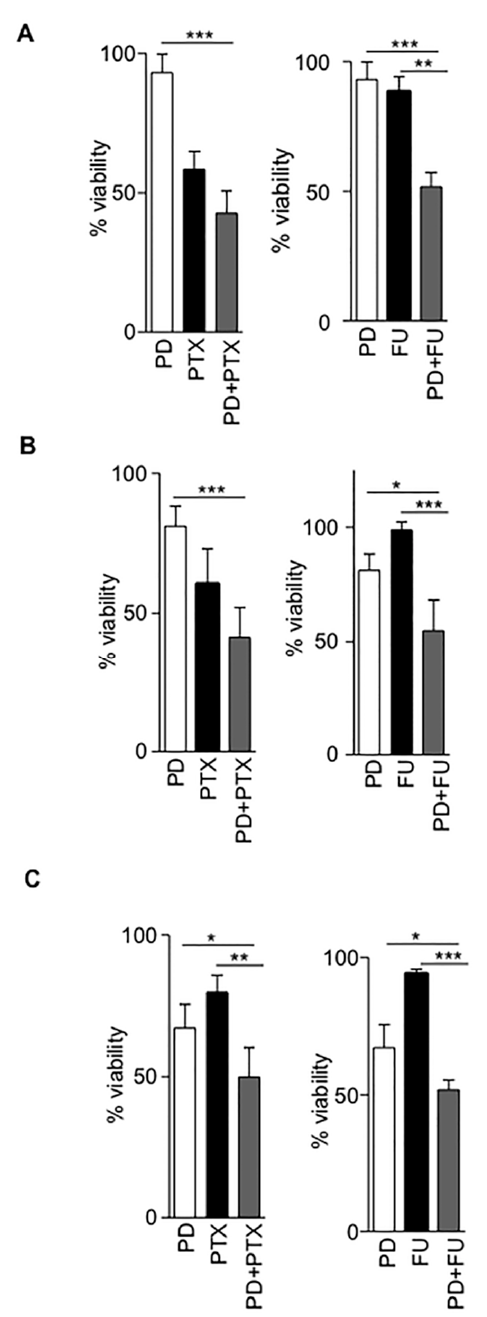
Figure 5. Pharmacological activation of SAMHD1 enhances cytotoxicity of antimetabolites. ( A – C ) E ff ect on cell viability of palbociclib–pemetrexed combination in TZM-bl, T47D and MDA-MB-468 cell lines, respectively. Left panels, cytotoxic activity of palbociclib alone (5 µ M, white bars), pemetrexed alone (black bars at 0.2, 1 or 0.04 µ M for TZM-bl, T47D and MDA-MB-468 respectively) or the combination of both drugs at the same concentration (grey bars). Right panels, cytotoxic activity of palbociclib alone (5 µ M, white bars), fluorouracil alone (5 µ M, black bars) or the combination of both drugs at the same concentration (grey bars). Drug concentrations were chosen depending calculated CC 50 under specific experimental conditions (Table S1). * p < 0.05; ** p < 0.005; *** p < 0.0005. PD, palbociclib; PTX, pemetrexed; FU,